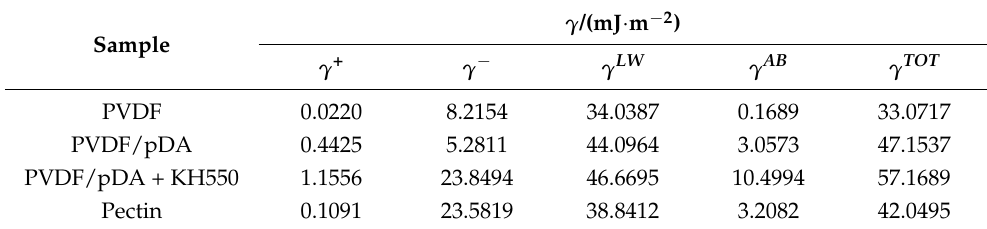
Table 5. Surface tension of membranes and pectin.